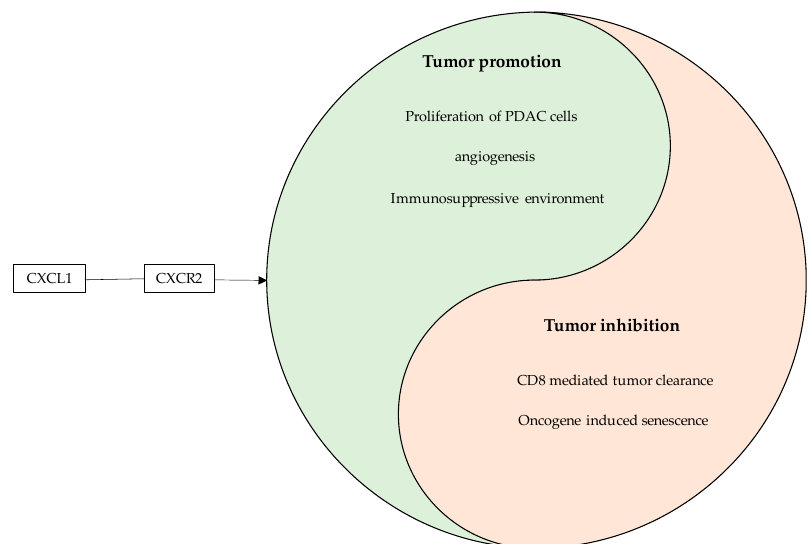
Figure 2. Contradictory effects of CXCL1-CXCR2 signaling in PDAC. Illustration of the Yin and Yang like effects of the CXCL1/CXCR2 interactions. Cancers 2019 , 11 , x FOR PEER REVIEW